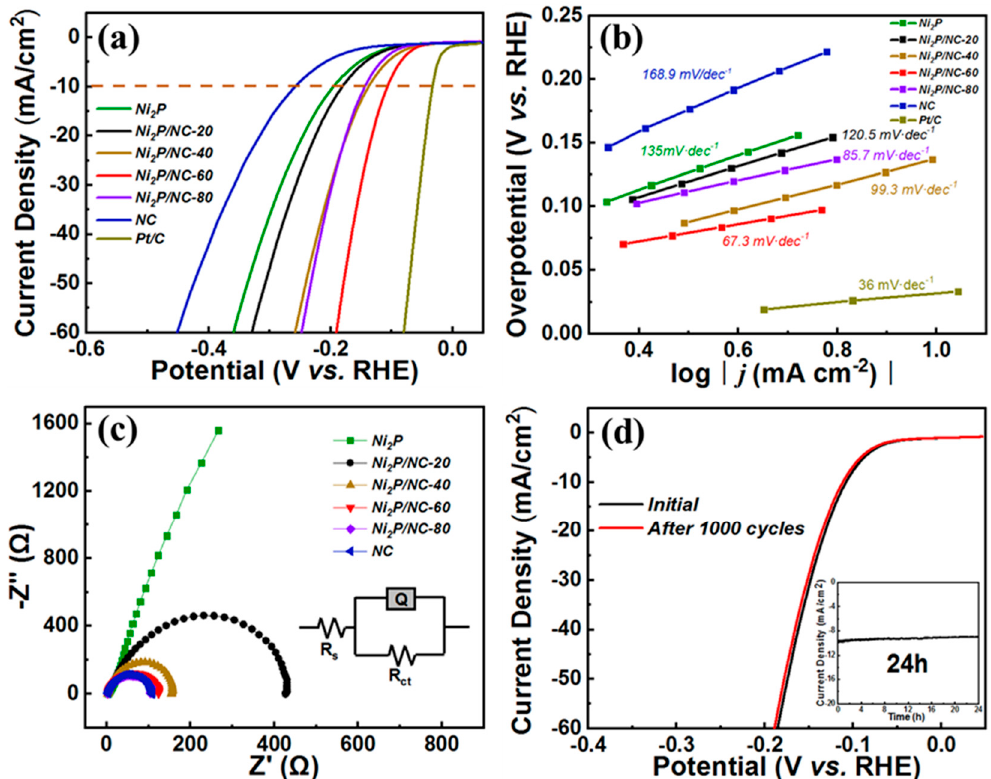
Figure 5. Profiles of different electrocatalytic experiments: ( a ) Linear sweep voltammetry (LSV) curves of Pt/C, Ni 2 P, Ni 2 P/NC-20, Ni 2 P/NC-40, Ni 2 P/NC-60, Ni 2 P/NC-80 and NC electrodes in 1 M KOH solution. ( b ) Tafel plots of Pt/C, Ni 2 P, Ni 2 P/NC-20, Ni 2 P/NC-40, Ni 2 P/NC-60, Ni 2 P/NC-80 and NC. ( c ) Nyquist plots of the Ni 2 P, Ni 2 P/NC-20, Ni 2 P/NC-40, Ni 2 P/NC-60, Ni 2 P/NC-80 and NC electrodes in 1 M KOH with a fitted equivalent circuit (inset). ( d ) LSV curves of Ni 2 P/NC-60 before and after 1000 cycles, the inset is the time dependence of current density curve at the potential of − 105 mV vs. RHE in 1 M KOH.